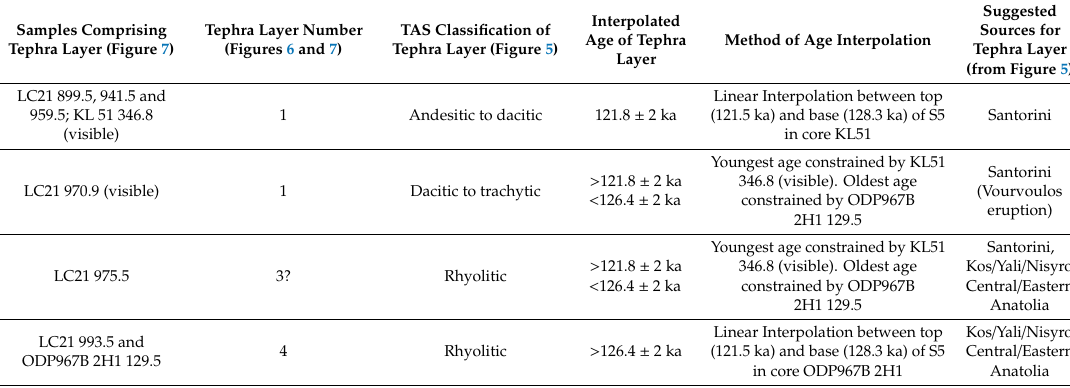
Table 1. Summary of correlations, interpolated ages and suggested sources of tephra layers in Mediterranean Sapropel S5. Ages are derived from linear interpolation between the ages for the top (121.5 ka) and base (128.3 ka) of S5 [54]. Samples Comprising Tephra Layer Number Tephra Layer (Figure 7) (Figures 6 and